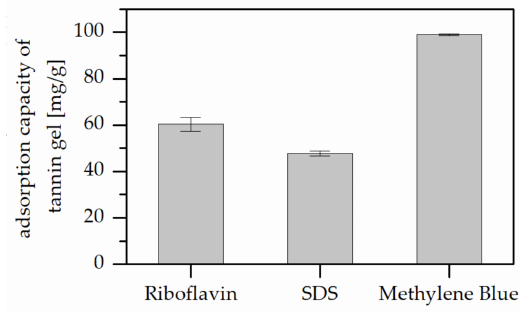
Figure 2. Adsorption capacity of the tannin gel against di ff erent